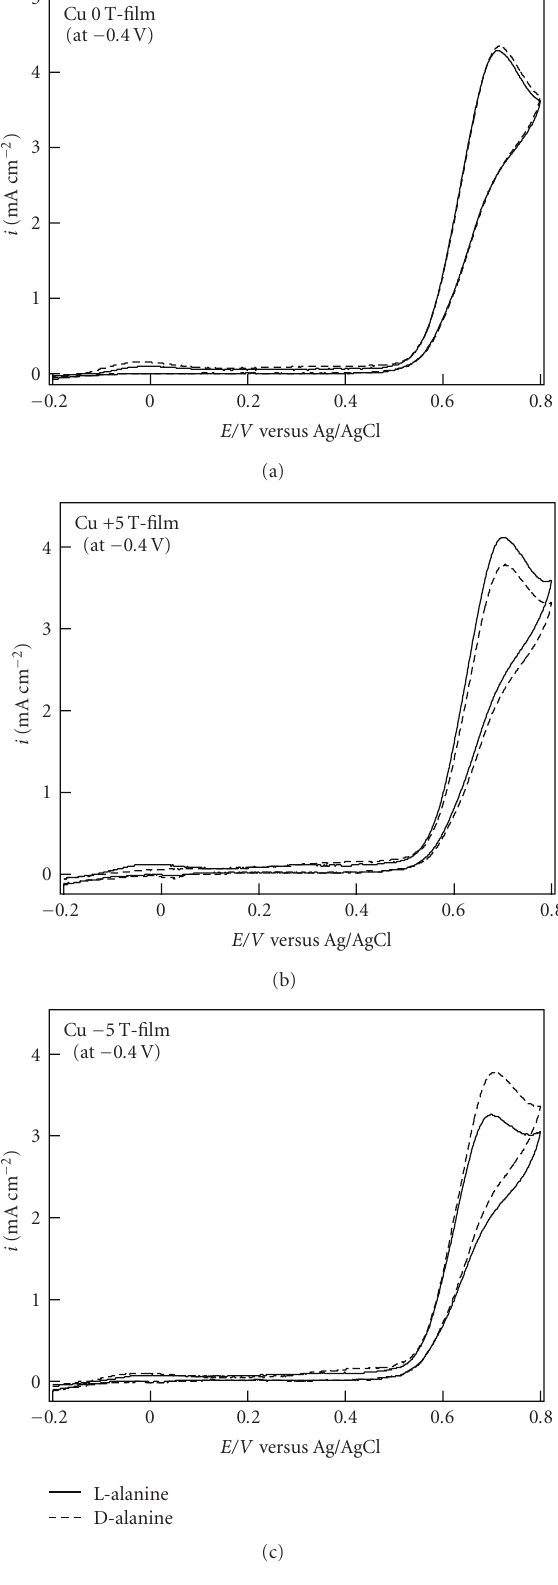
Figure 4: CVs of 20mM L- and D-alanines on the Cu (a) 0T-film, (b) +5T-film,and (c) − 5T-film electrodes in a 0.1MNaOHaqueous solution. The potential sweep rate was 10mVs − 1 .